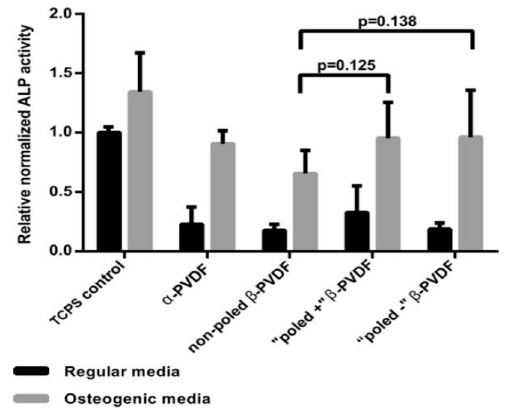
Figure 21. Relative alkaline phosphatase activity of hASCs on different PVDF films and tissue culture polystyrene (TCPS) control. The ALP activity was normalized against the DNA content of the cells. Reproduced with permission from [171], published by Wiley, 2015.